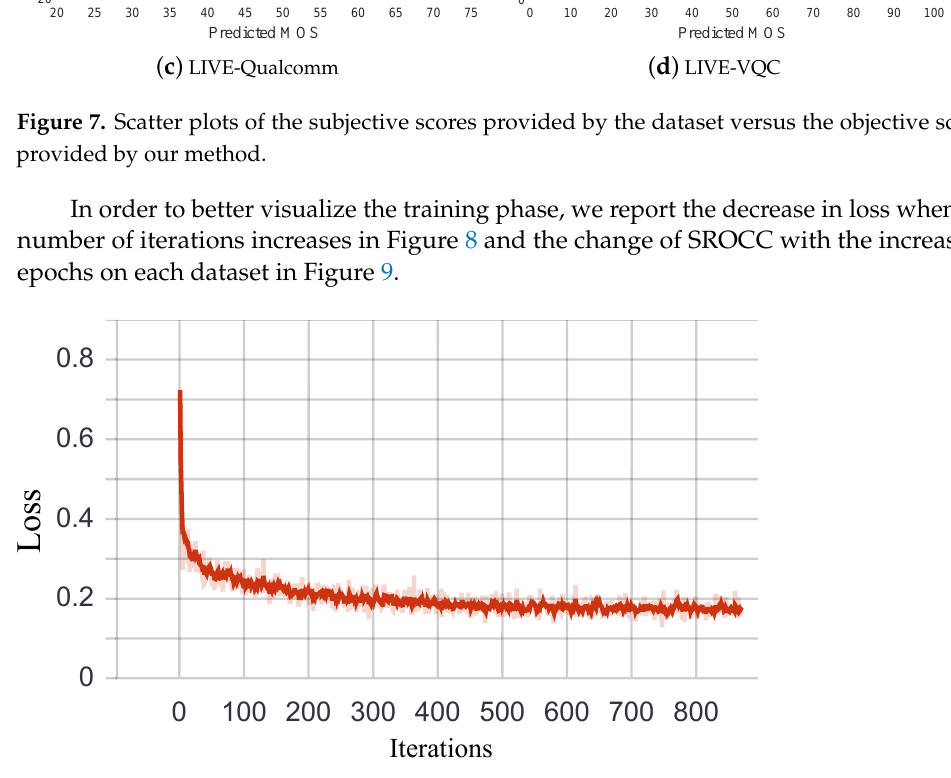
Figure 8. The relationship between loss value and the number of iterations in the training